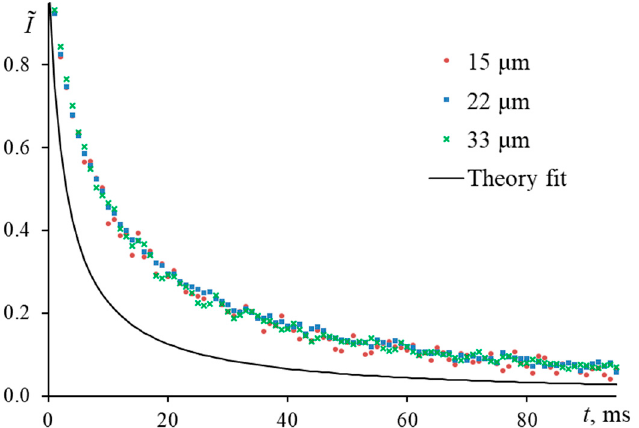
Figure 20. Normalized transient curves at the mode-mismatch factor m ≤ 1 for an aqueous solution of ferroin (2.5 µ mol/L); narrow-focused configuration ( ω e 0 = 33 µ m, Figure 1, Table 3). As 𝜔 (cid:3043)(cid:2869) and m increase, the experimental transient curves and the theoretical ones